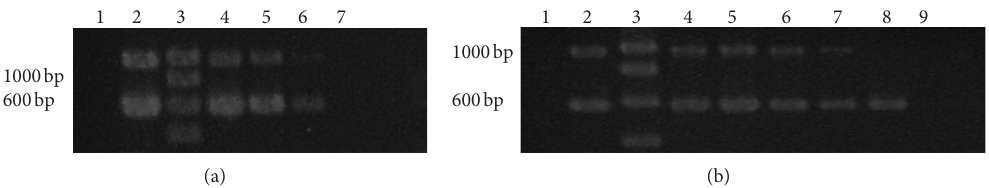
Figure 2: Comparison of DNA extraction methods from milk. Detection of sub0888 and sub1154 in S. uberis 0140 J spiked milk from (a) PowerFood Microbial DNA Isolation kit detected to a level of 2 × 10 6 cfu/ml and (b) phenol:chloroform extraction detected to a level of 2 × 10 4 cfu/ml.